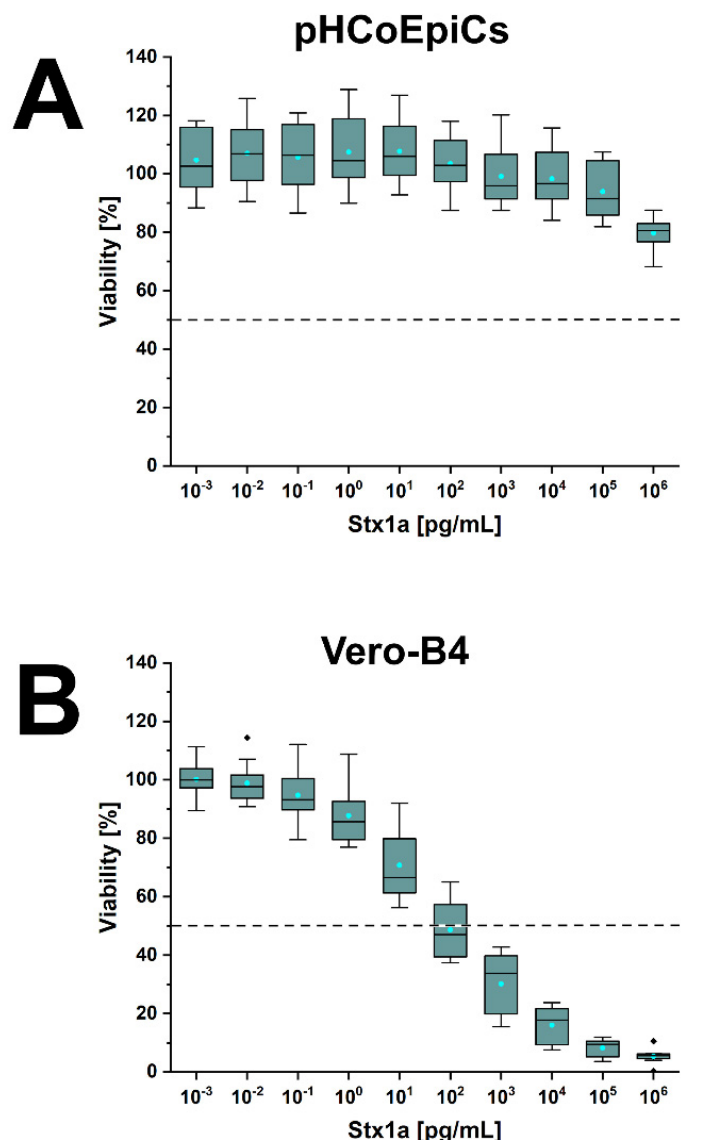
Figure 10. Cytotoxic effect of Stx1a towards pHCoEpiCs ( A ) and Vero-B4 reference cells ( B ). The cell-damaging activity was analyzed with the crystal violet assay, and absorption readouts of Stx1a- challenged cells are presented as box plots. Percentages of cell damage were determined in relation to parallel cell cultures without toxin serving as 100% viability control.